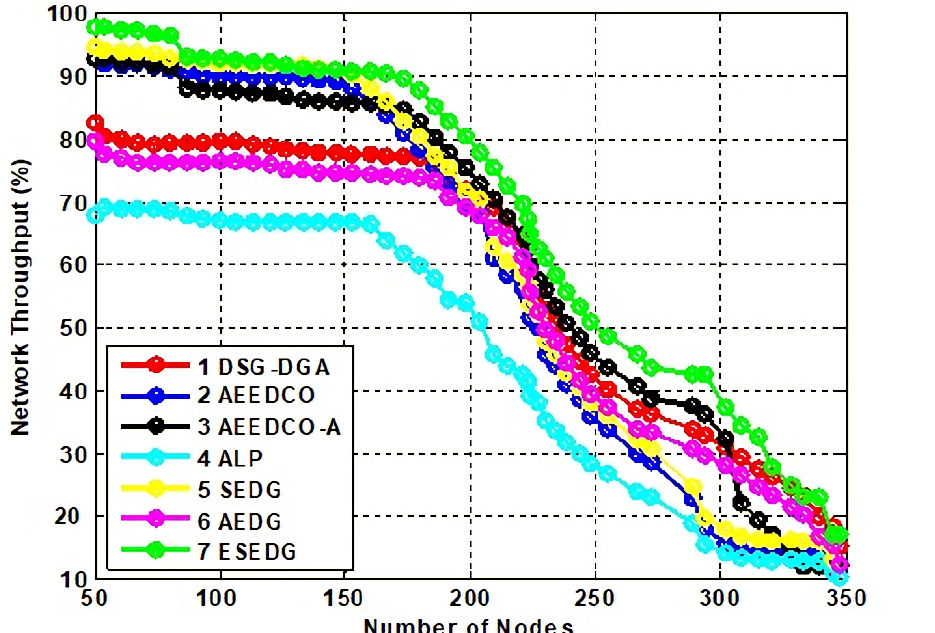
Figure 8. Analysis of network throughput loss with baseline schemes.